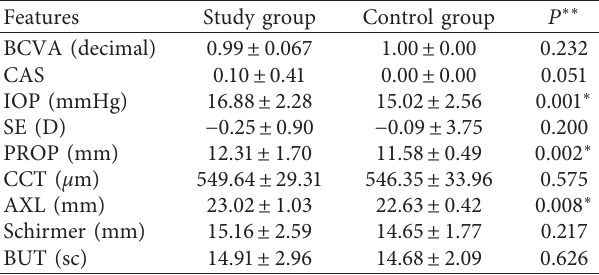
Table 1: Comparison of mean pre-OCT-A features of the eyes of patients in the study group and the eyes of the subjects in the control group (study group, n � 58; control group, n � 60).